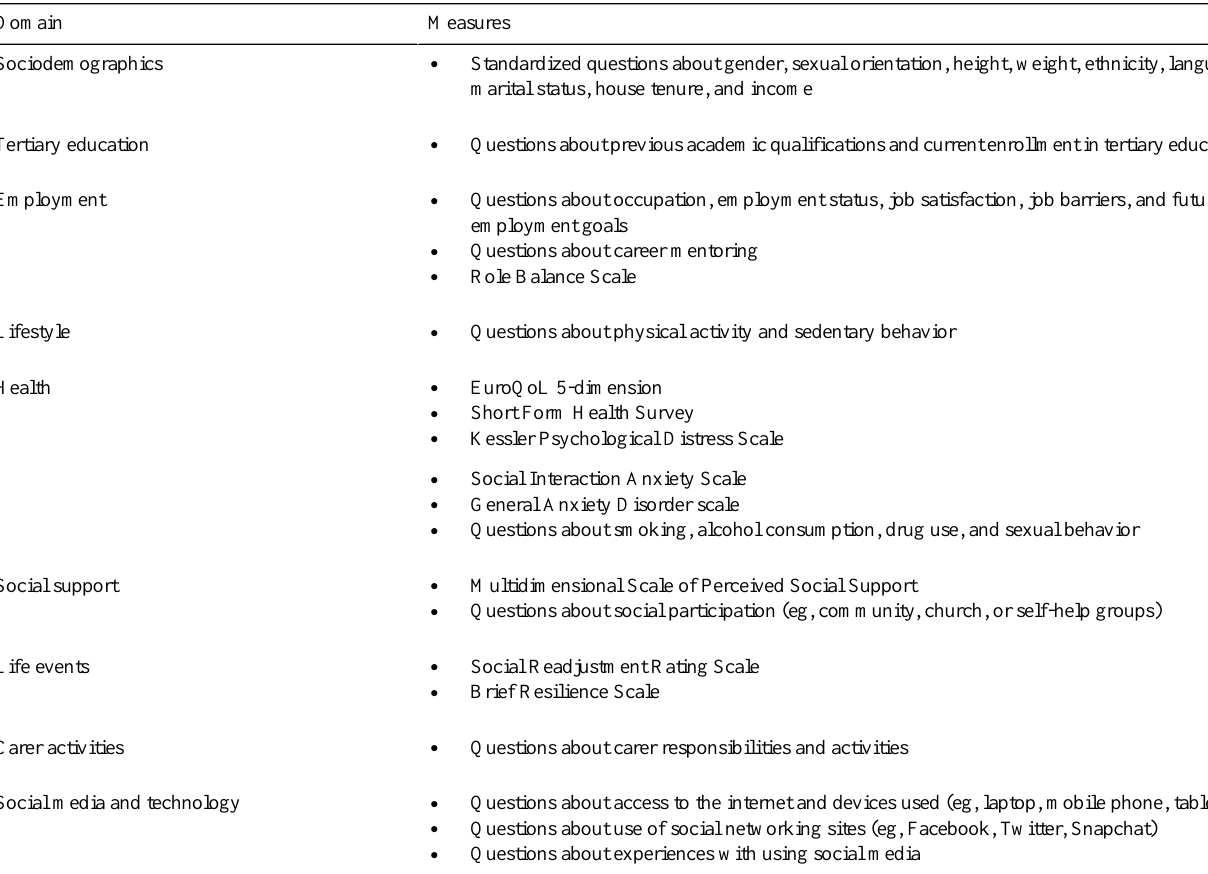
Table 1. Overview of survey domains and